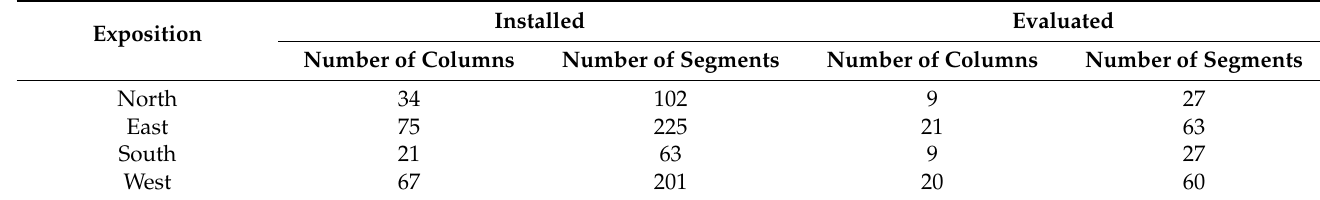
Table 5. Structural description of the green